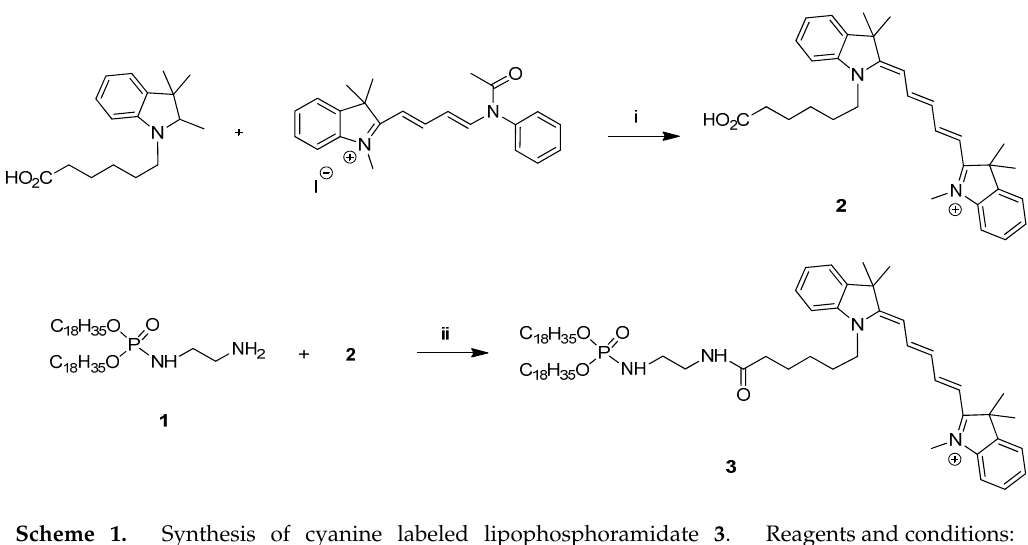
Scheme 1. Synthesis of cyanine labeled lipophosphoramidate 3 . Reagents and conditions: i. Pyridine, 40 °C, 1.5 h; and ii. EDC, DMF/THF, RT, 18 h; Compound 1: O , O -dioleyl- N